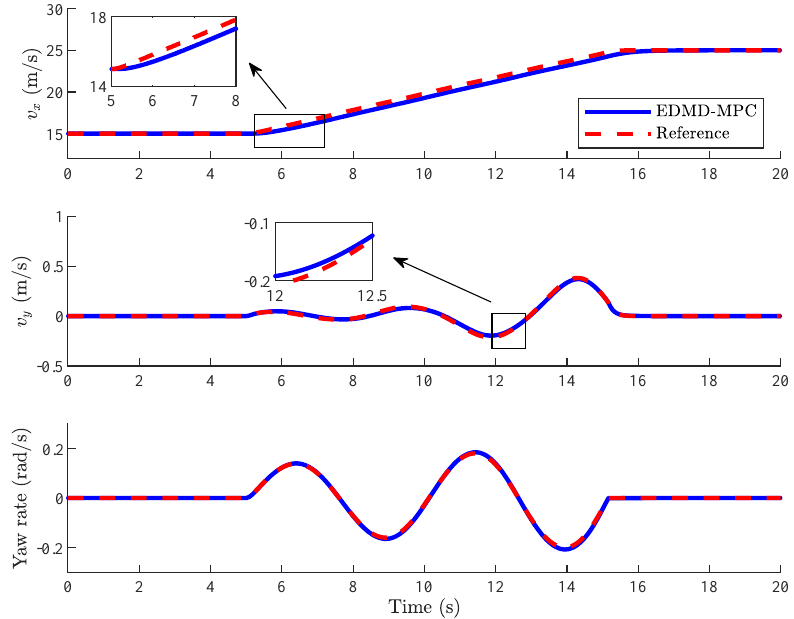
Figure 14. State evolution of EDMD-MPC (Case